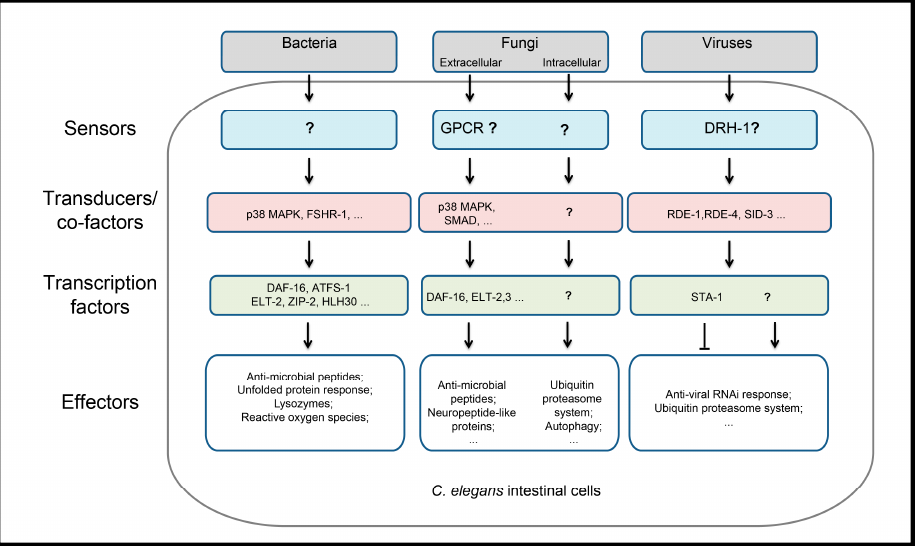
Figure 2. Known host genes that interact with bacterial, fungi and viruses in C. elegans intestinal cells. MAPK: Mitogen-Activated Protein Kinase; FSHR: Follicle Stimulating Hormone Receptor;